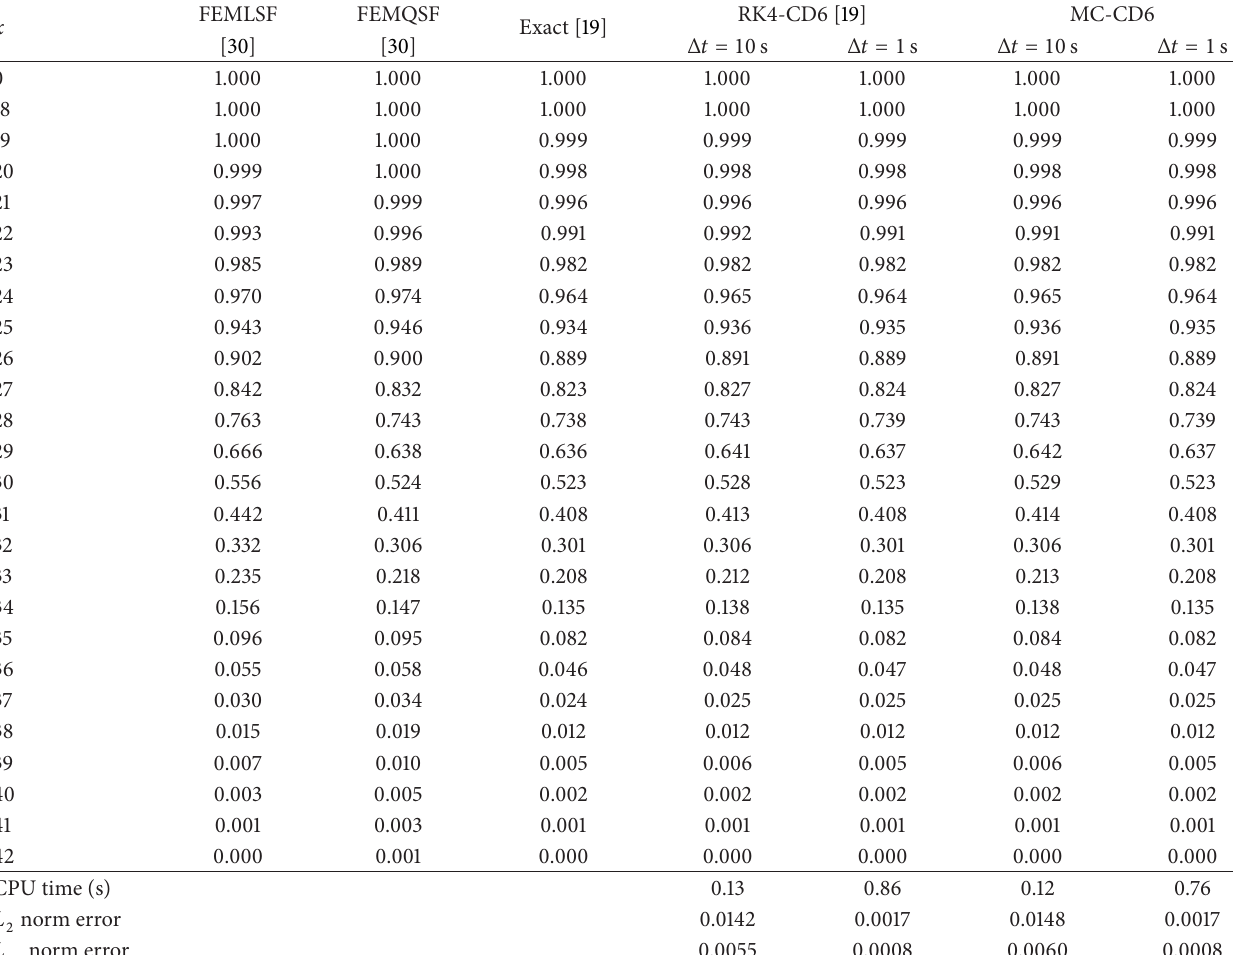
Table 1: Comparison between numerical solutions and the exact solution.